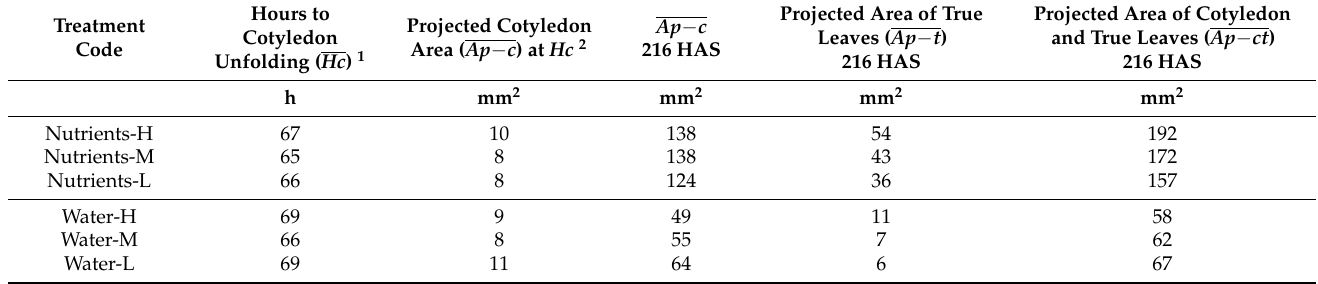
Table 3. Average hours to cotyledon unfolding ( Hc ), projected areas of cotyledon ( Ap − c ) both at cotyledon unfolding and 216 h after sowing (HAS), true leaves ( Ap − t ), and the sum of Ap-c and Ap-t ( Ap − ct ), with nutrients and water, each with distributions of horizontal PPFDs (see Table 1 for treatments and